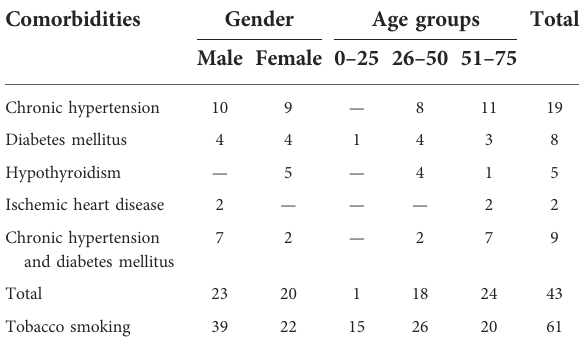
TABLE 1 Patient distribution with reference to comorbidities and tobacco smoking within gender and age groups.